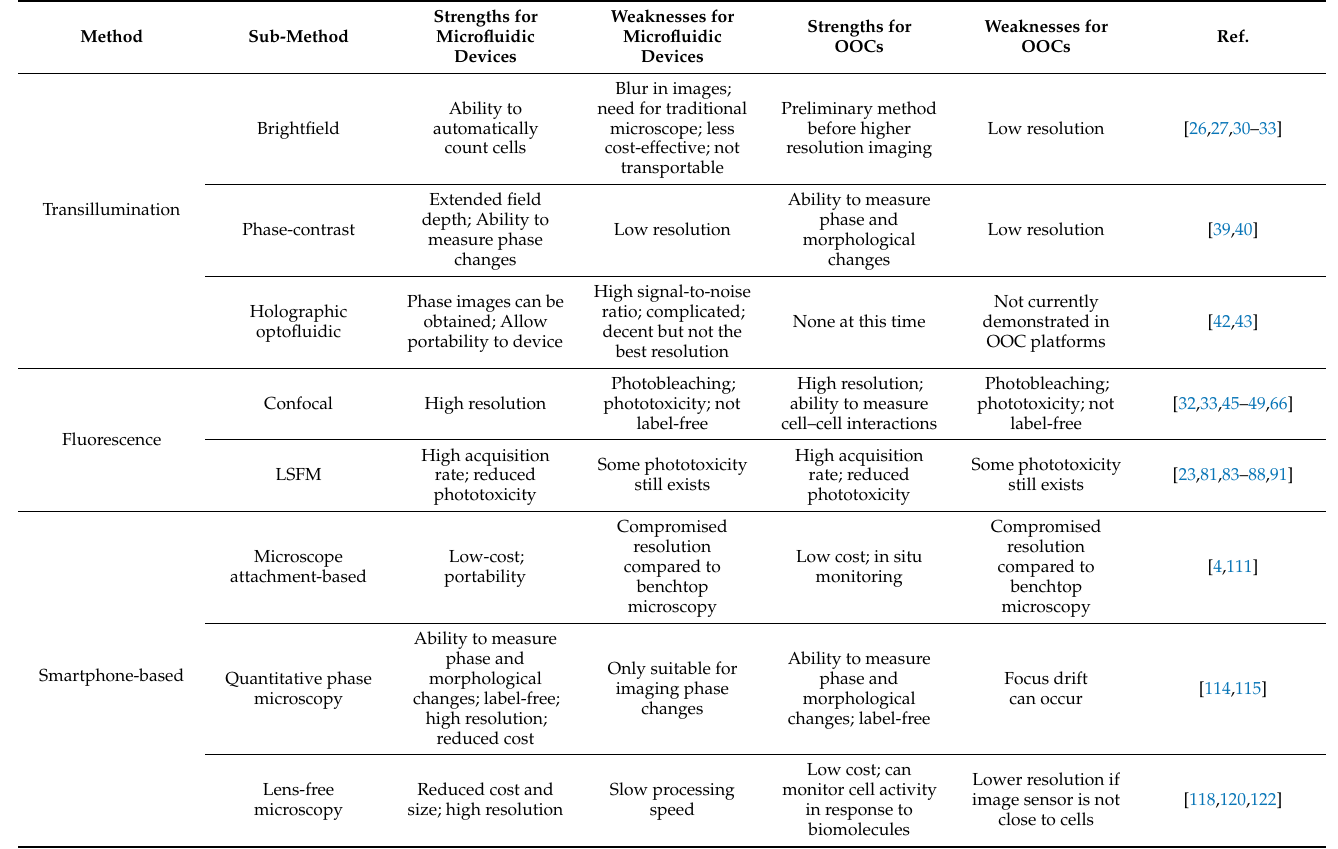
Table 1. Summary of the imaging methods discussed in this review and their strengths and weak- nesses when used to image microfluidic devices and OOC